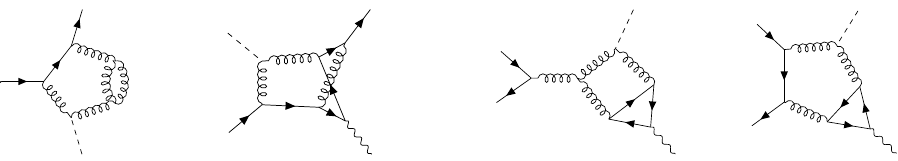
Figure 2: Sample non-singlet (first two) and singlet (last two) diagrams at the next- to-leading order in